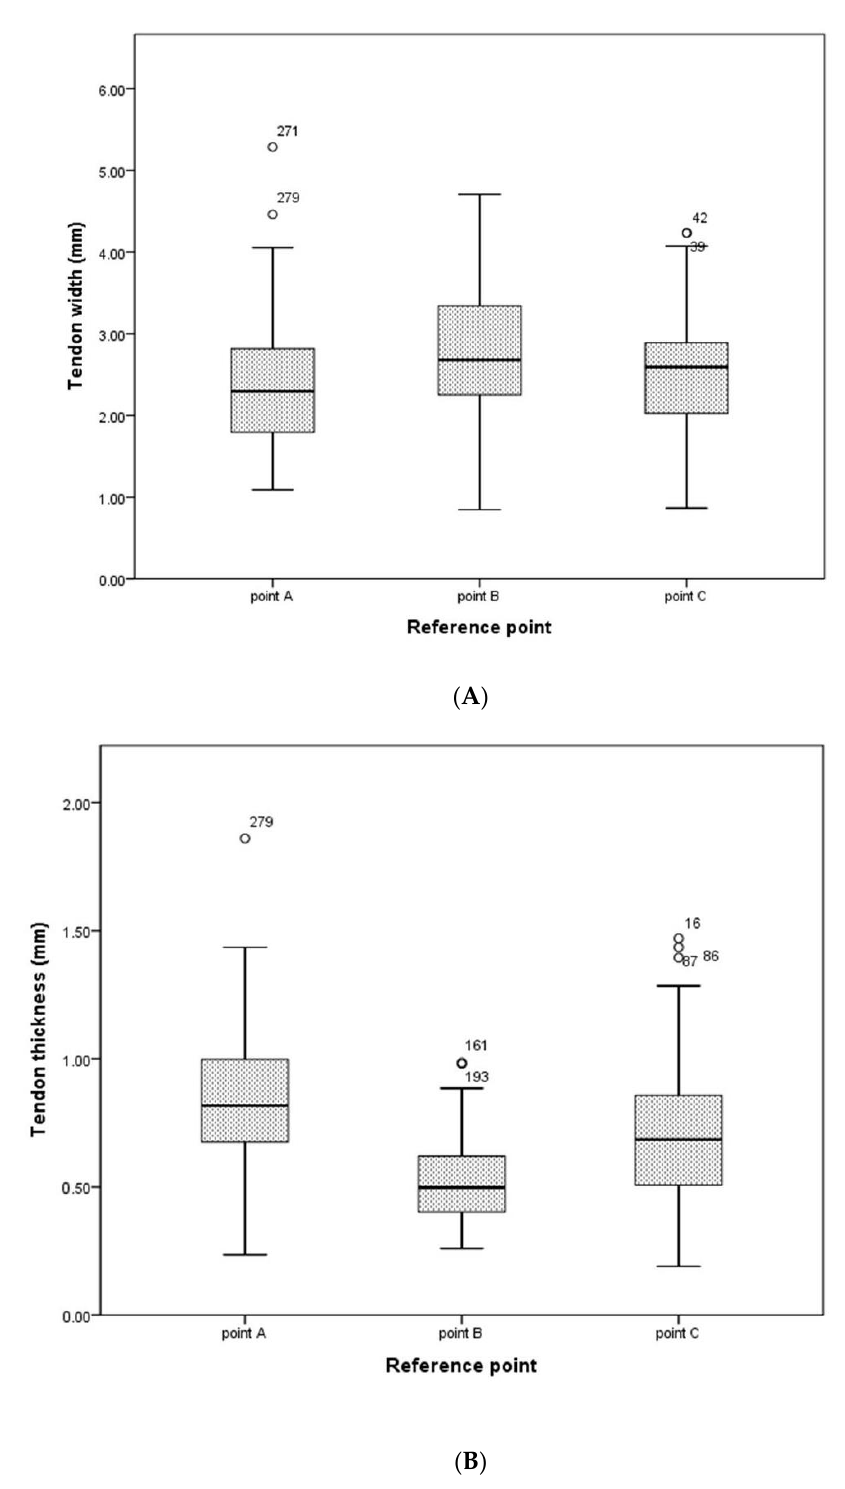
Figure 4. Boxplot of thickness and width of PT for each reference point ( n = 101). ( A ) Distribution of the width of the PT for each reference point and ( B ) distribution of PT thickness for each reference point. Interquartile ranges are expressed as boxes, the median is the thick horizontal line inside the box, and the range is the horizontal line below and above the box. Point A is the junction point of the tendon and belly, point B is the mid-point for the total tendon length, and point C is the point where the tendon begins to extend.